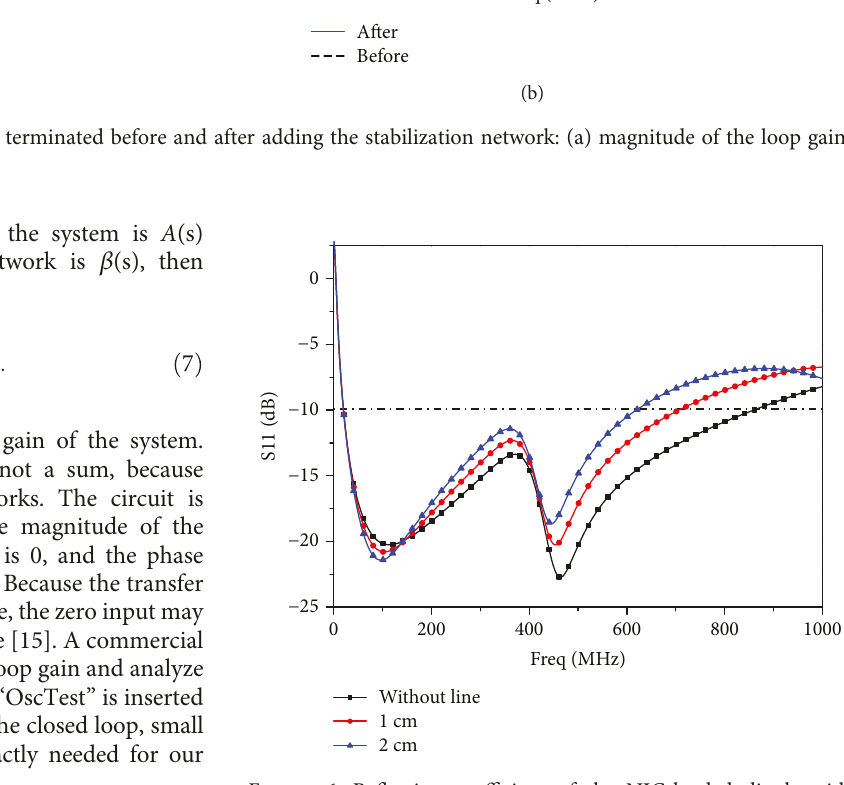
Figure 6: Re fl ection coe ffi cient of the NIC-loaded dipole with di ff erent lengths of the interface transmission